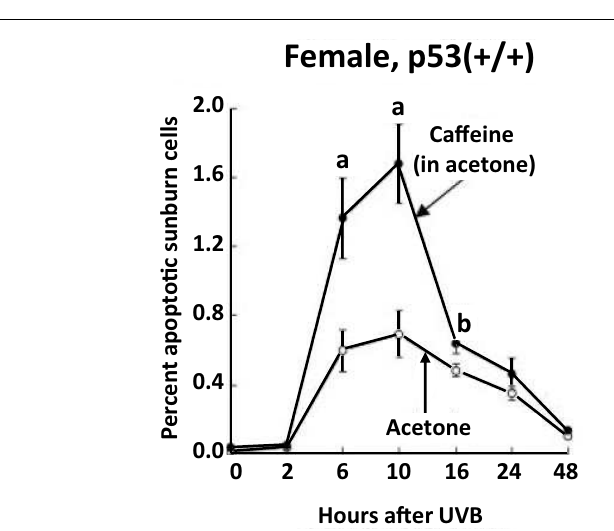
FIGURE 4 | Stimulatory effect of topical application of caffeine on UVB-induced apoptosis in the epidermis of p53 knockout mice . Female p53( + / + ) and p53(-/-) mice (7–8weeks old, five mice for each time interval) were treated with 100 µ l of acetone or caffeine (1.2mg; 6.2 µ mol) in 100 µ l of acetone immediately after UVB (60mJ/cm 2 ) and 0.5 and 2h later.The animals